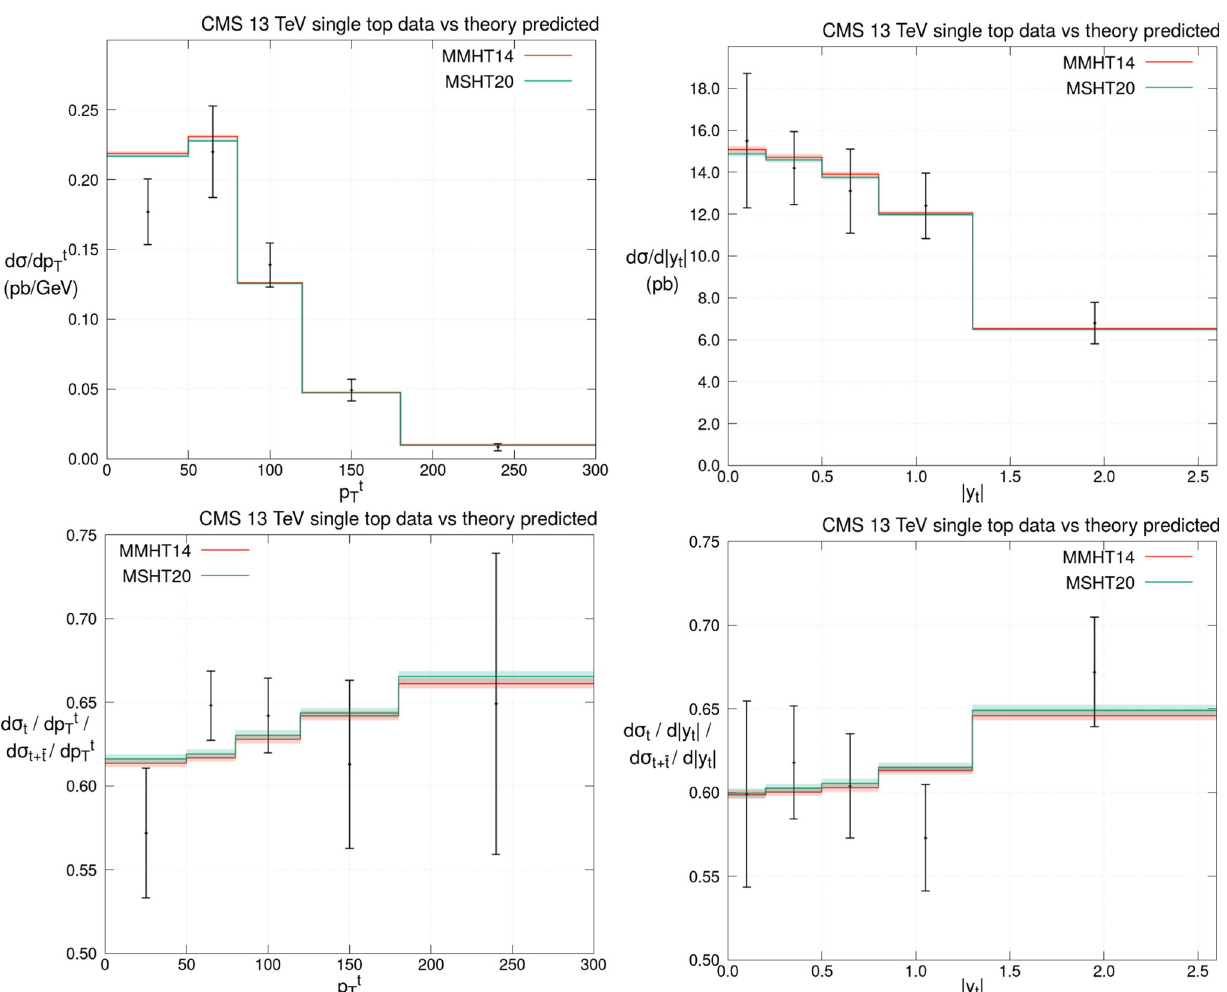
Fig. 85 MMHT14 and MSHT20 NNLO predictions for the t -channel single top and anti-top production. We compare to the sum t + t (upper plots) and the ratio of t to the total t + t (lower plots) at 13 TeV, dif- ferential in the top/antitop p ⊥ (left-hand plots) and rapidity (right-hand